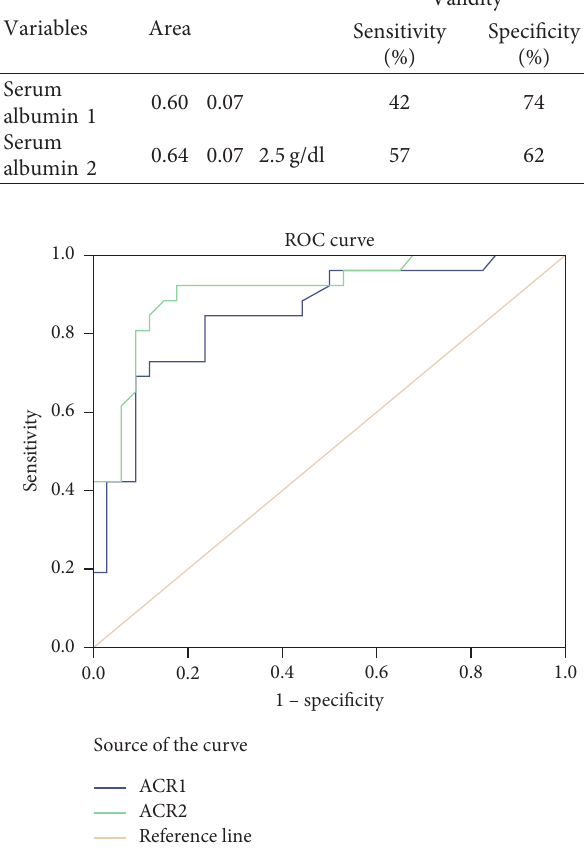
Figure 1: ROC curve analysis of ACR1 and ACR2 as prognostic markers of ICU mortality.